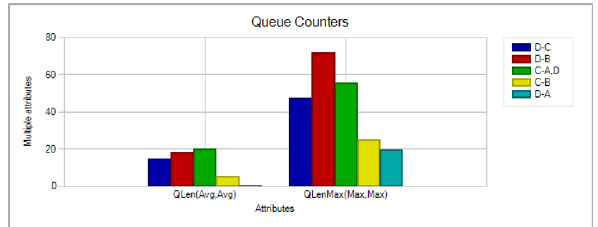
Figure 14: Maximum and average line lengths for the 2nd modified intersection